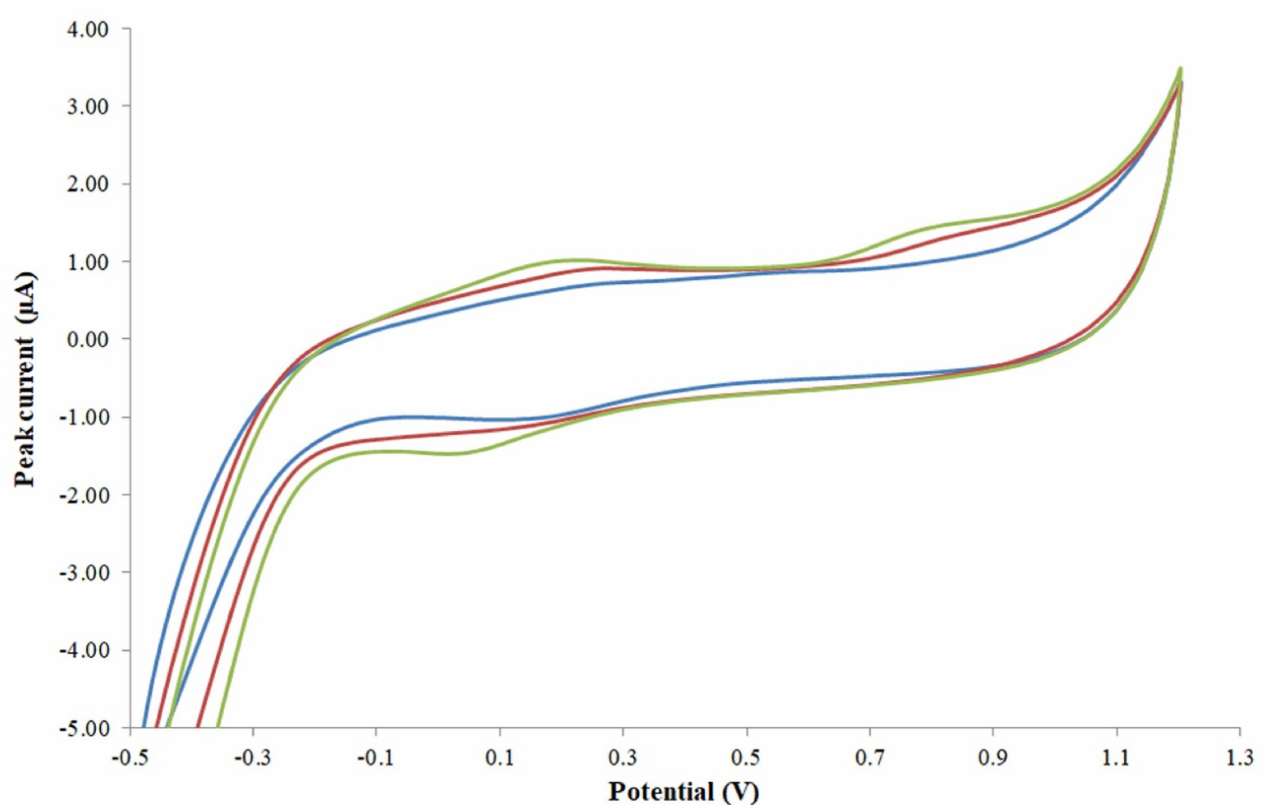
Figure 1. Voltammograms of different SNGCEs obtained from CV scanning: ‘blue: after polishing and polarizing 1’, ‘red: after polishing and polarizing 2’, ‘green: after polishing and polarizing